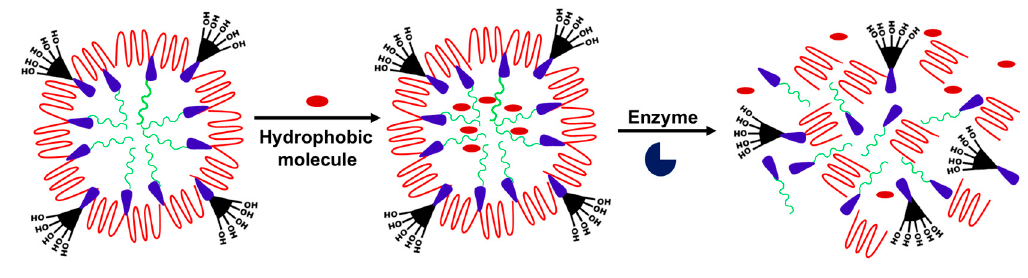
Figure 5. Enzyme-triggered systematic release of hydrophobic molecules from amphiphilic polymers.